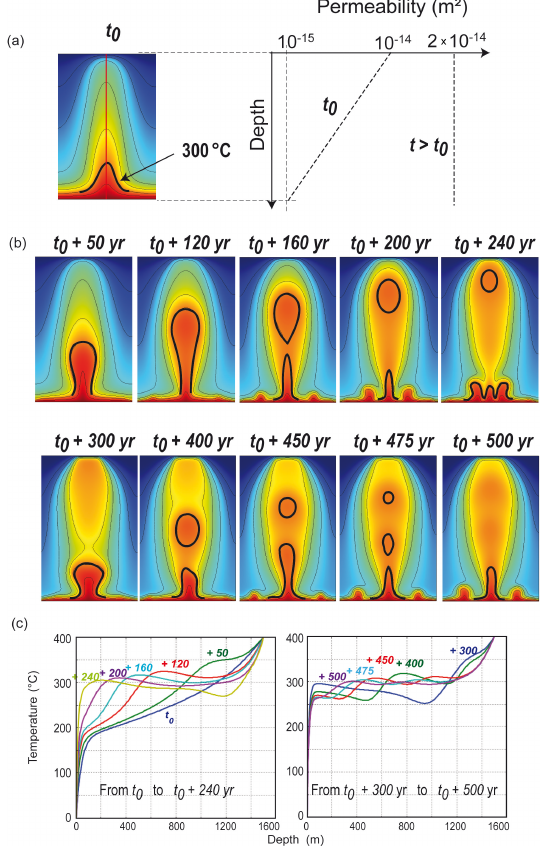
Figure 7. Instantaneous increase in the medium permeability (from 10 − 14 exp ( − z/ 650 ) at t = t 0 , to 2 × 10 − 14 m 2 , at t > t 0 ) result- ing in a high-velocity upwelling, wherein the central blob does not lose much energy during ascent. (a) Steady-state triangular-like up- welling at t = t 0 and permeability function; (b) temporal evolu- tion of the convective pattern showing the detachment of a high- temperature “blob” ( T > 300 ◦ C); (c) plots of vertical temperature profiles taken at the blob vertical axis (red vertical line in the top left pattern) for each time step shown in (b) . The color bar (not shown) is the same as in previous